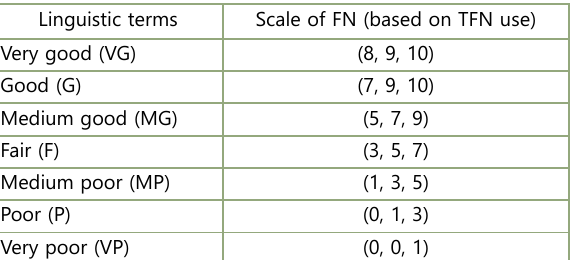
Table 4. Linguistic variables for the evaluation of alternatives (Rudnik, Kacprzak 2017)) Linguistic